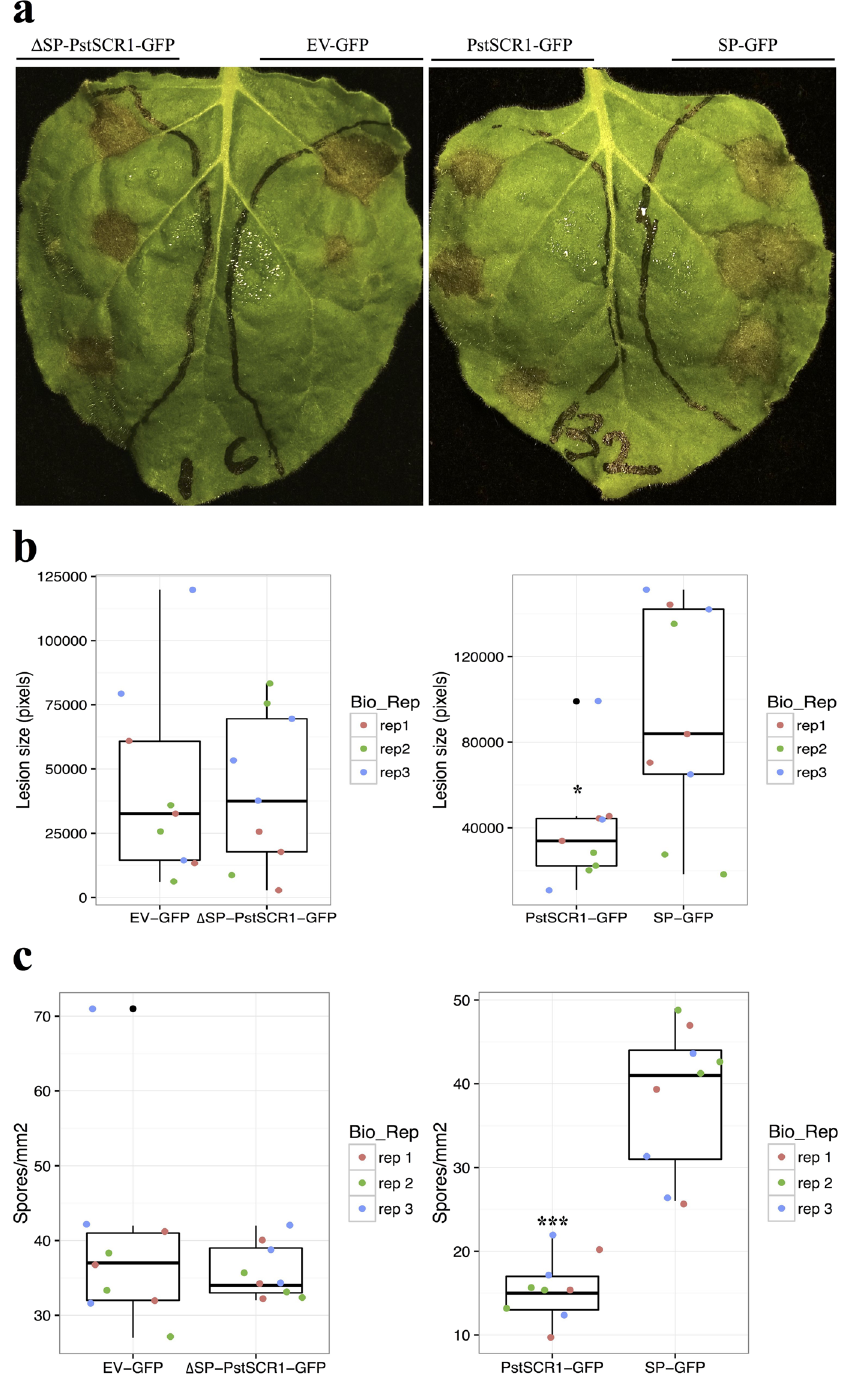
Figure 1. Expression of PstSCR1 reduces infection capacity of oomycete pathogens. ( a ) The infection of N . benthamiana leaf with P . infestans after expressing Δ SP-PstSCR1-GFP and PstSCR1-GFP constructs. Photographs were taken after 8-dpi. ( b ) P . Infestans lesion sizes were reduced in leaves expressing PstSCR1- GFP in a SP-dependent manner. Leaf patches expressing PstSCR1-GFP showed significantly smaller lesions compared to leaves expressing SP-GFP, whereas patches expressing Δ SP-PstSCR1-GFP showed similar lesion sizes to those expressing EV-GFP, as measured in pixels (by ImageJ tool). Asterisk indicates significant differences by ttest ( * P ≤ 0.05). ( c ) Peronospora hyoscyami f . sp . tabacina spore count was reduced in leaves expressing PstSCR1-GFP in a SP-dependant manner. N . benthamiana leaves were infected with P . tabacina and spores were counted 8-dpi. Leaf patches expressing PstSCR1-GFP showed significantly less spores than patches expressing SP-GFP, whereas patches expressing Δ SP-PstSCR1-GFP showed similar spores to those expressing EV-GFP. Asterisks indicate significant differences by ttest ( *** P ≤